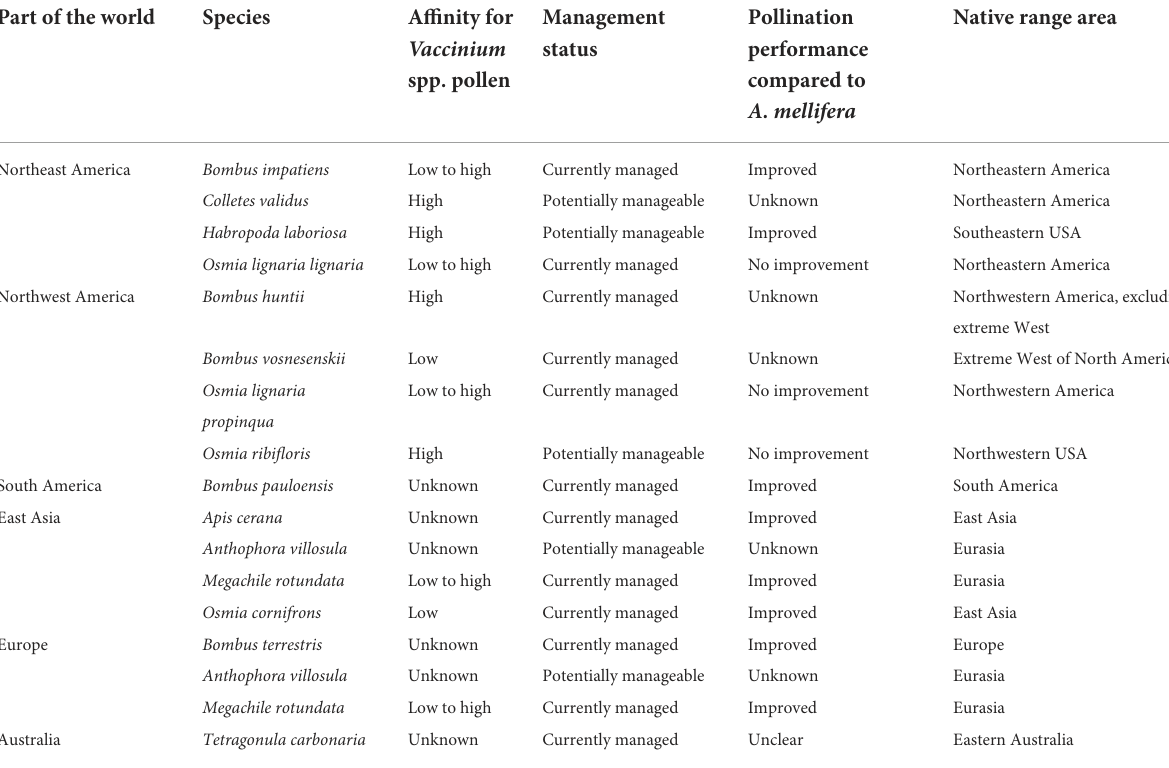
TABLE 1 Alternative managed pollinator species other than the western honey bee ( Apis mellifera L.) for highbush blueberry ( Vaccinium spp.) pollination. Part of the